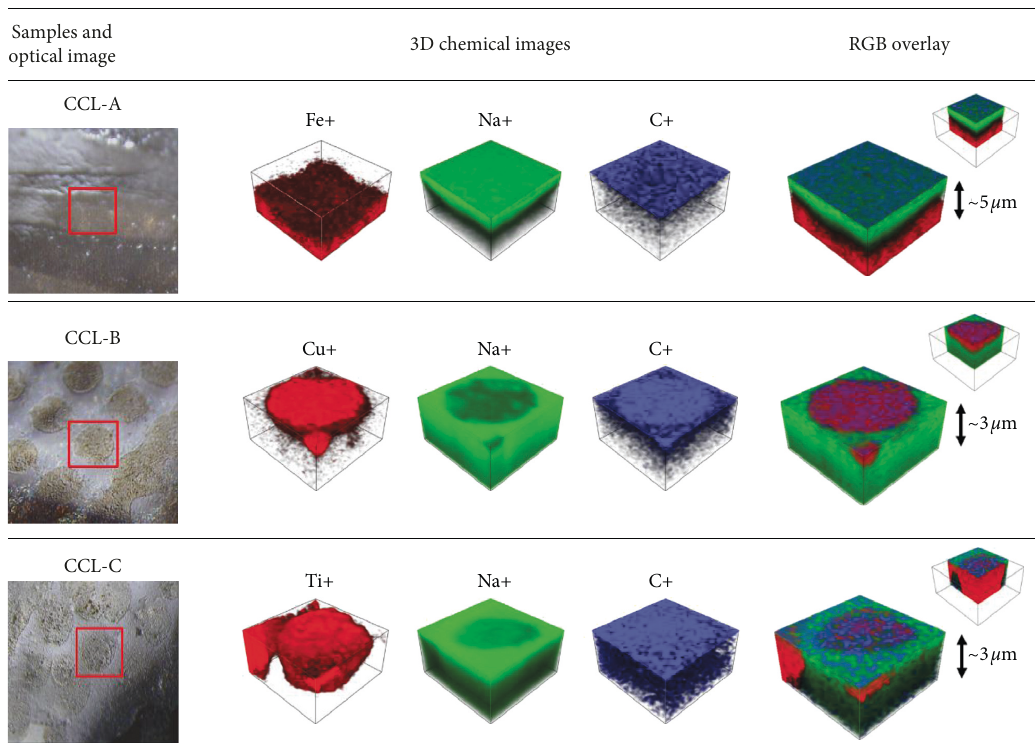
Figure 7: Optical images of the analysis area and 3D chemical images by